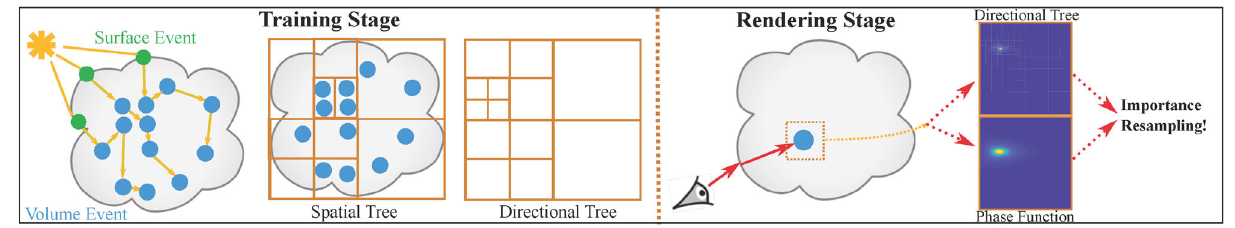
Fig. 7 Our algorithm has a training step and a rendering step. In the former, we learn the incoming radiance distribution iteratively. In each iteration, light rays are shot from light sources, scattered in the participating media, and stored in a spatial-directional hierarchy. In the rendering step, the camera rays are scattered in the media, while the outgoing direction sampling method is chosen by considering the anisotropy of the phase function. For highly anisotropic media, the outgoing directions are sampled via the resampling product of the learned incoming radiance and the phase function. For low anisotropic media, the outgoing directions are sampled via multiple importance sampling of these